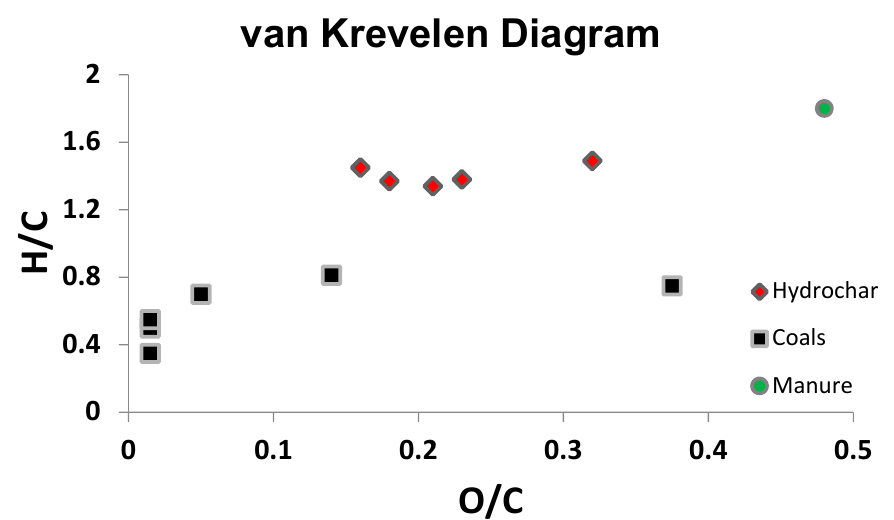
Figure 2. The van Krevelen plots for manure-derived hydrochars and coals (H/C vs. O/C).